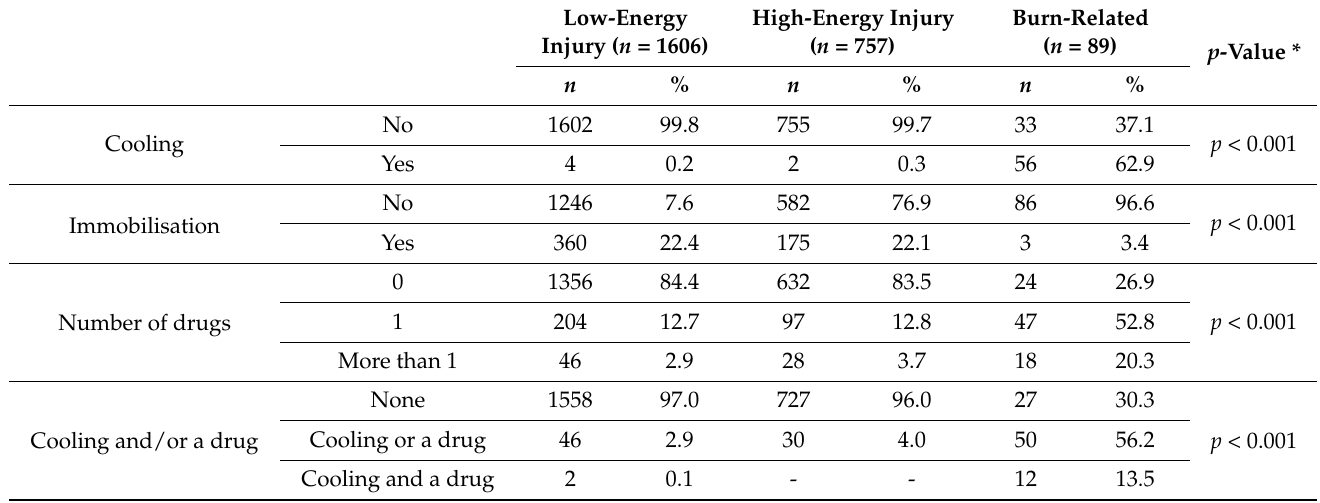
Table 6. An analysis of the relationship between the mechanism of injury and the use of non-pharmacological methods or drugs of